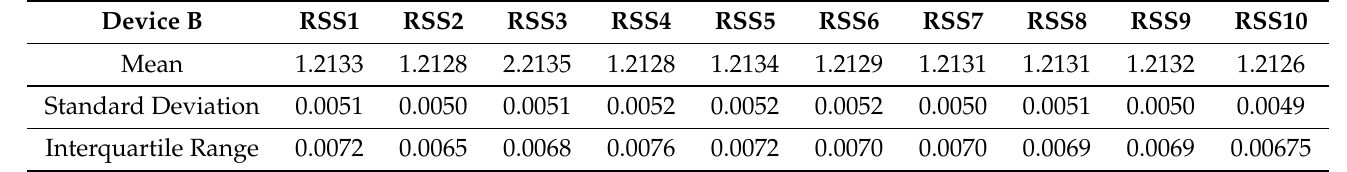
Table 5. Statistical overview of mean, standard deviation and interquartile between groups for Device